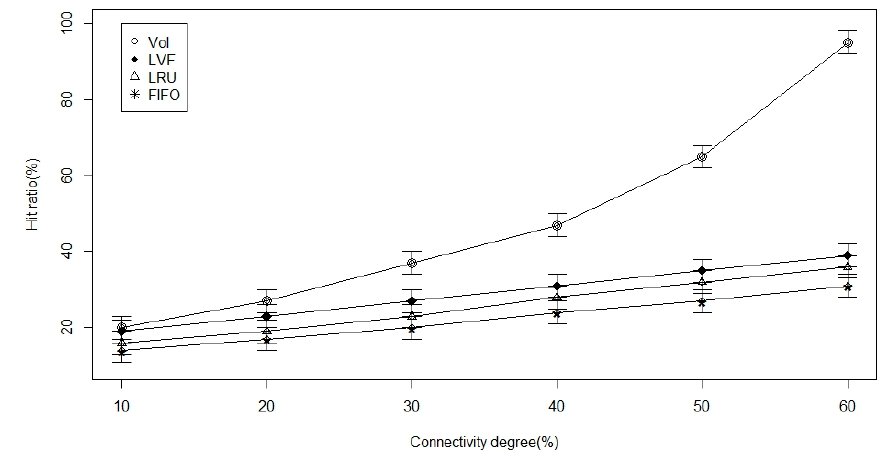
Figure 9. Hit ratio versus the connectivity degree percentage.